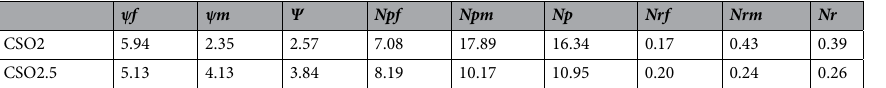
Table 2. Female and male fertility variation, and the effective number in two seed orchards. ψf variations of female among clones, ψm variations of male among clones, ψ sibling coefficient of combined fertility variation, Npf the effective number of female, Npm the effective number of male, Np the effective number of parents, Nrf the relative effective number of female, Nrm the relative effective number of male, Nr the relative effective number of